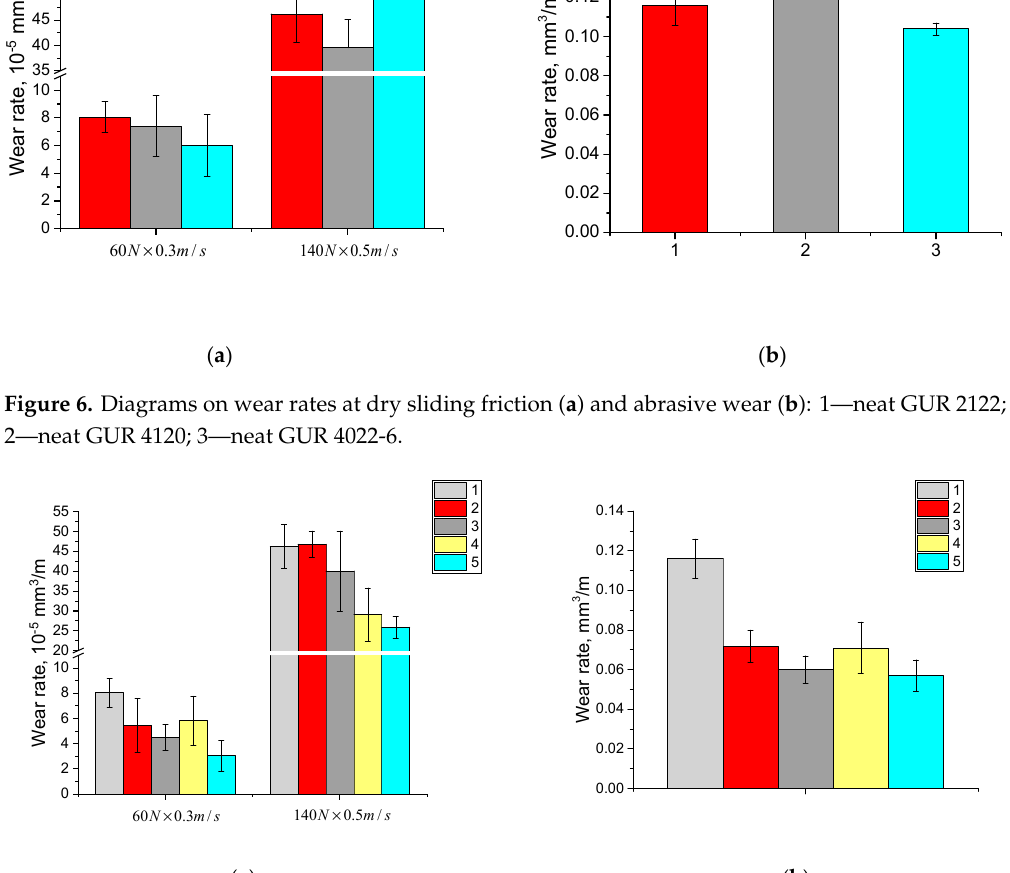
Figure 7. Diagrams on wear rates at dry sliding friction ( a ) and abrasive wear ( b ): 1—neat GUR 2122; 2—“GUR 2122 + 10% MGF annealed” composite; 3—“GUR 2122 + 10% MGF annealed and treated with “KH-550”” composite; 4—“GUR 2122 + 10% LGF annealed” composite; 5—“GUR 2122 + 10% LGF annealed and treated with “KH-550”” composite.